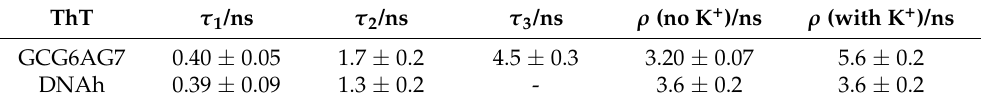
Table 2. Fluorescence lifetimes ( τ ) and rotational correlation times ( ρ ) of ThT bound to GCG6AG7 and ThT bound to DNAh obtained by global analysis of the time-resolved fluorescence and anisotropy decays, respectively. The lifetime τ 1 is a very short lifetime with low contribution to the observed fluorescence, which is attributed to a small proportion of ThT molecules undergoing TICT [52]. ThT τ 1 /ns